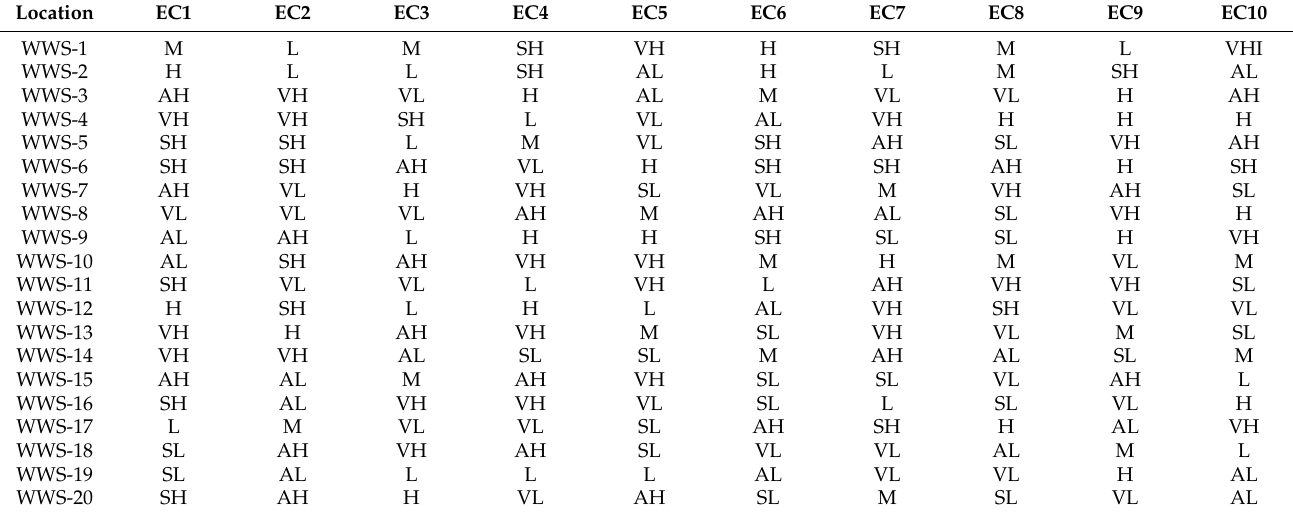
Table A5. Linguistic evaluation by Expert 1.